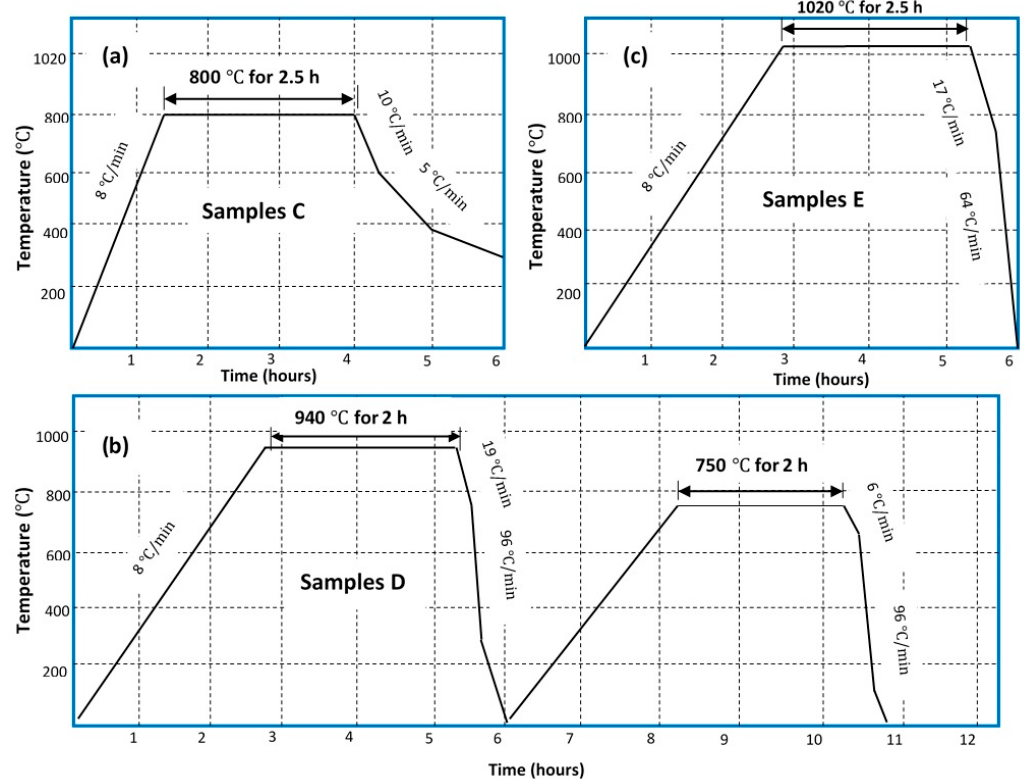
Figure 2. Heat treatment cycles for high temperature annealed DMLS Ti6Al4V(ELI) for ( a ) samples C, ( b ) samples D and ( c ) samples E, all after the initial stress relieving heat